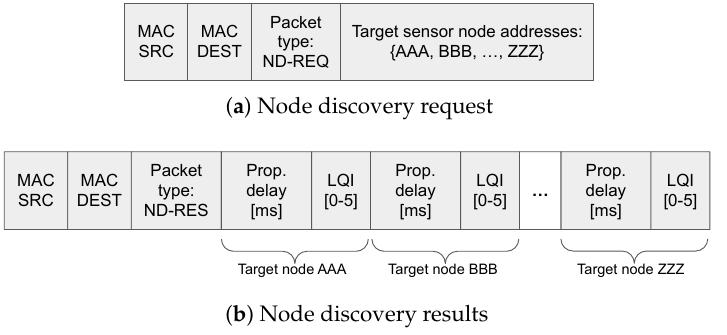
Figure 6. Network discovery protocol packet structure.